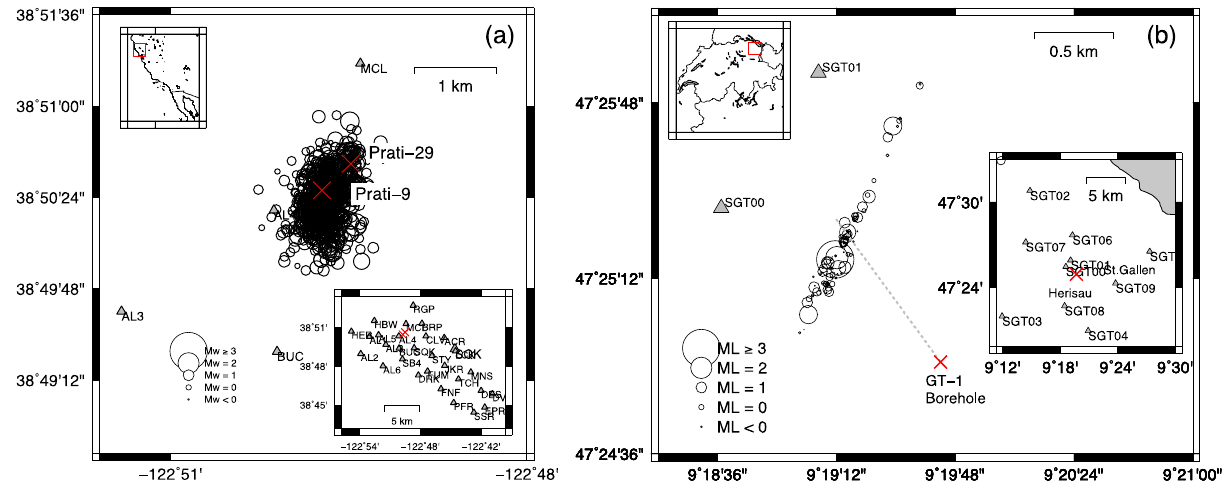
Figure 1. Geographic distribution of the analysed seismicity. ( a ) Epicentral distribution of the earthquakes and seismic network configuration for The Geysers, California, geothermal field. The two red crosses indicate the location of the Prati-9 and Prati-29 injection wells. ( b ) Epicentral distribution of the earthquakes and seismic network configuration for the St. Gallen, Switzerland, geothermal field. The location of the GT-1 well is indicated with a red cross. The dashed line represents the surface projection of the well